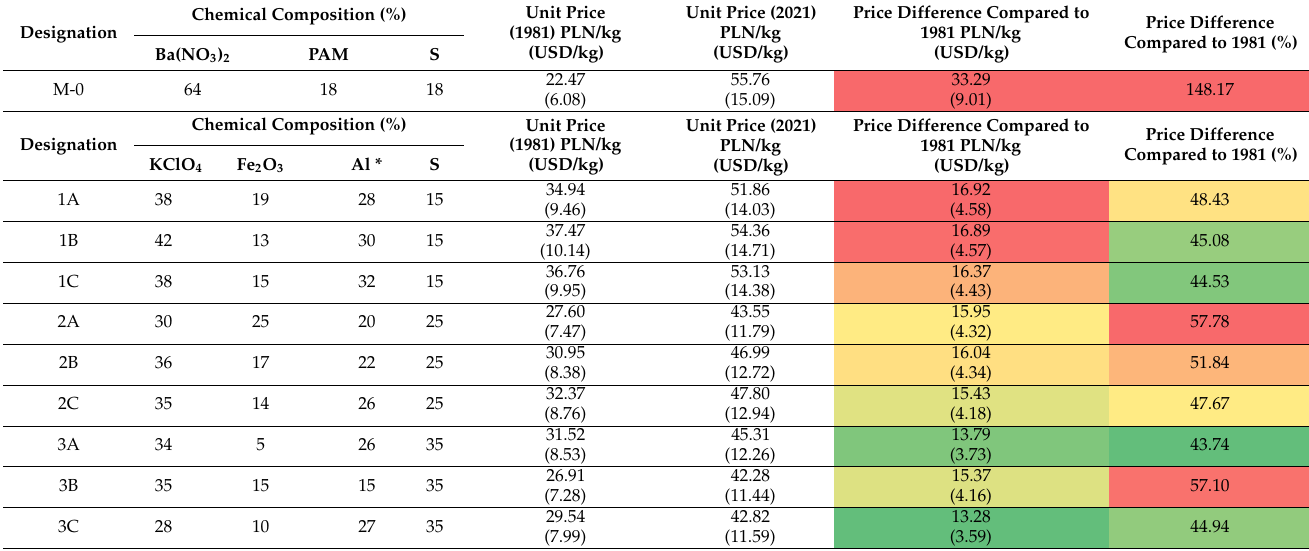
Table 7. Analysis of changes in unit prices of pyrotechnic compositions from the M-1 group and the M-0 comparison